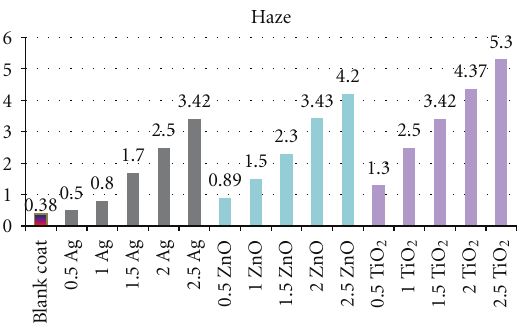
Figure 9: Haze values of the sol-gel film mixture with nanoparticles of silver (Ag), zinc oxide (ZnO), and titanium dioxide (TiO 2 ).